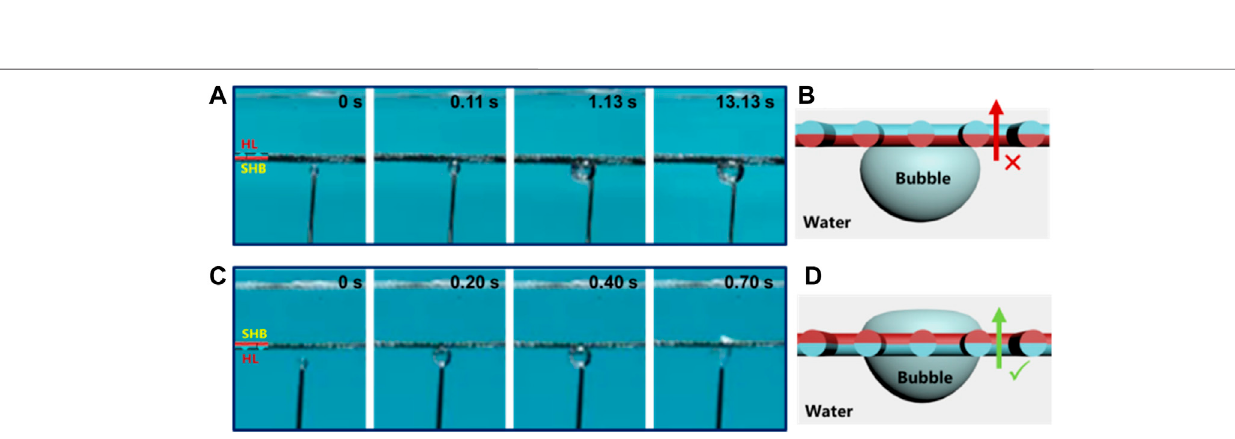
FIGURE 3 | Underwater bubble unidirectional penetration on the single-layer Janus CM fi xed horizontally in the water. (A) Air bubbles will be blocked from the superhydrophobic side to the hydrophilic side. (B) As the superhydrophobic surface is fi xed down, there is no Laplace pressure difference ( P L ), the bubble cannot penetrate the single-layer Janus mesh. (C) Air bubbles can easily pass through the single-layer mesh from the hydrophilic side to superhydrophobic side. (D) As the hydrophilic surface is fi xed down, the bubble can easily pass through the single-layer Janus mesh driven by the buoyant force ( F B ) and Laplace pressure difference ( P L